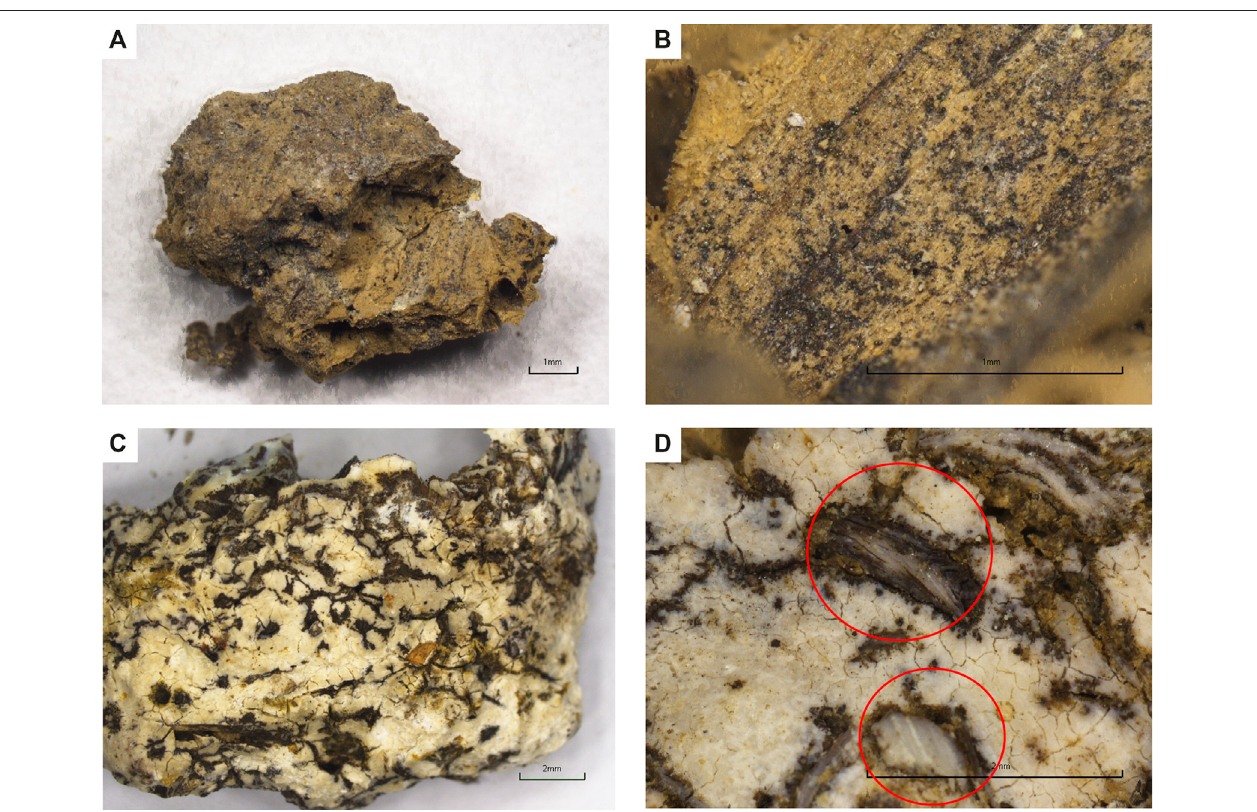
FIGURE 4 | Microscope photos of the cross sections of the coprolites. (A) Tianluoshan coprolite with incorporated plant materials. (B) Reticulate impressions of plant remains from the Tianluoshan coprolite. (C) Undigested bone fragments from the Yuhuicun coprolite. (D) Small bones (marked in red circle) incorporated in the Yuhuicun